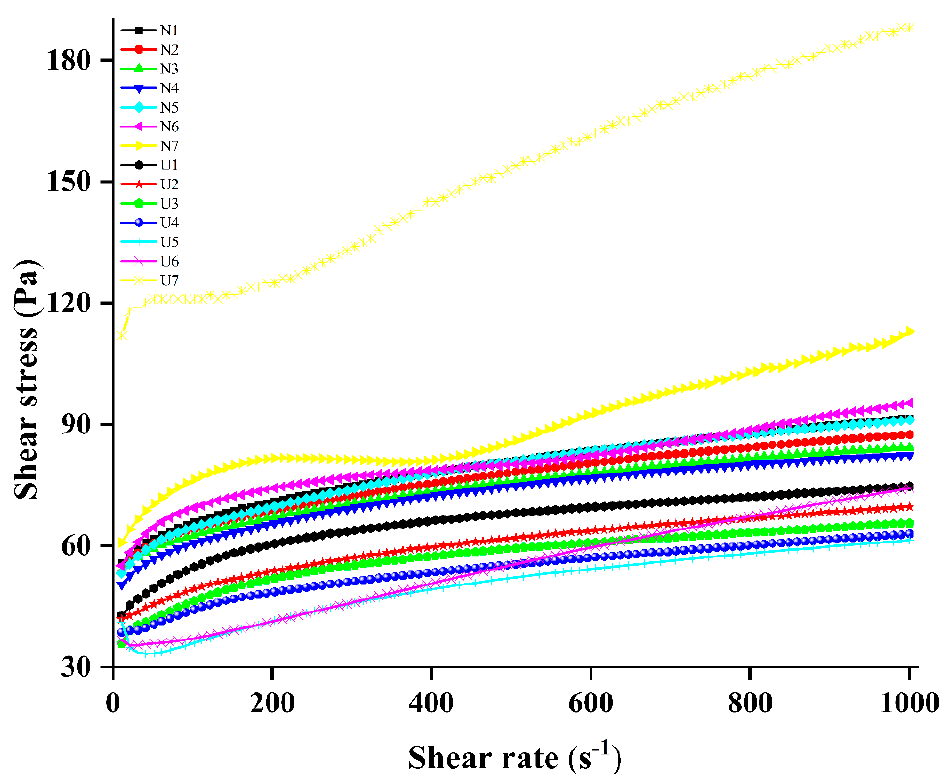
Figure 2. Changes in the shear rate and shear stress of emulsions as affected by high-intensity ultrasound emulsification.